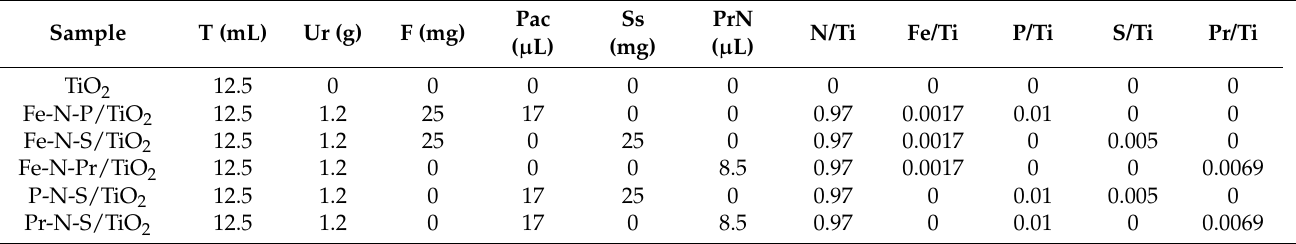
Table 4. List of all prepared photocatalysts, amount of titanium tetraisopropoxide(T), urea (Ur), iron acetylacetonate (F), phosphoric acid (Pac), sodium sulfate (Ss), and praseodymium nitrate hexahydrate (PrN) used for the synthesis and N/Ti, Fe/Ti, P/Ti, S/Ti, and Pr/Ti molar ratio